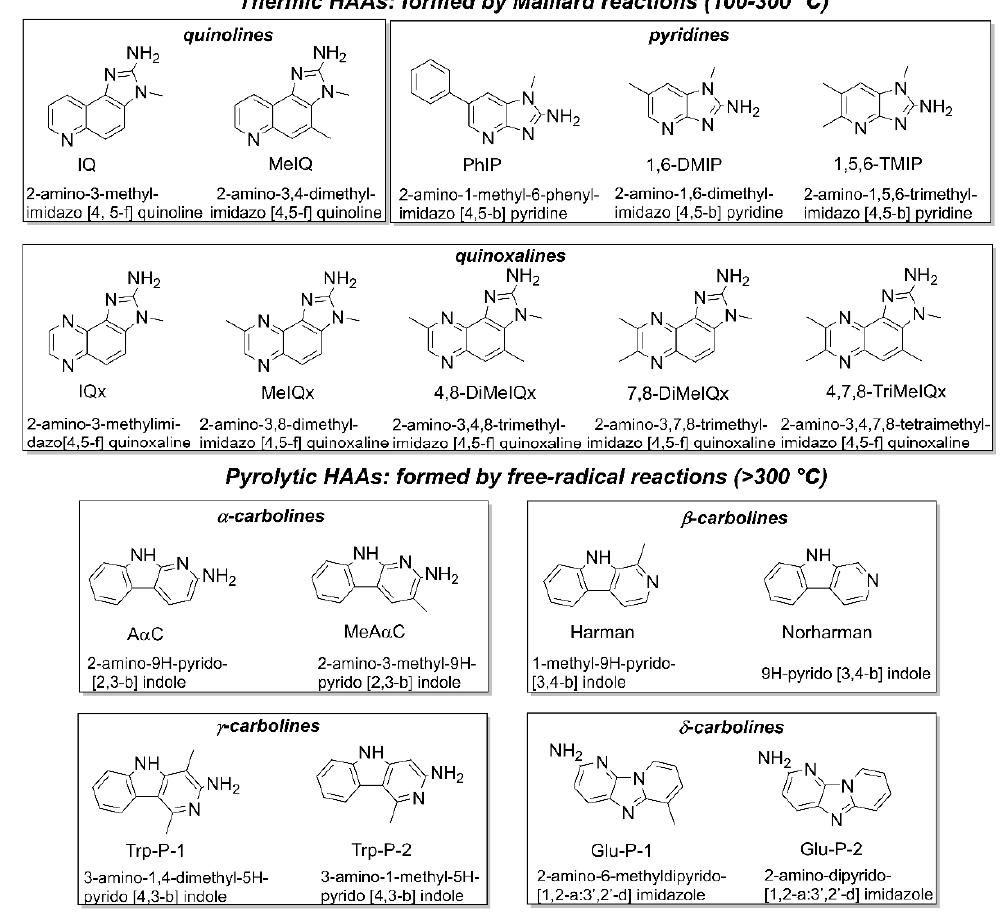
Figure 1. Names and molecular structures of common heterocyclic aromatic amines (HAAs).